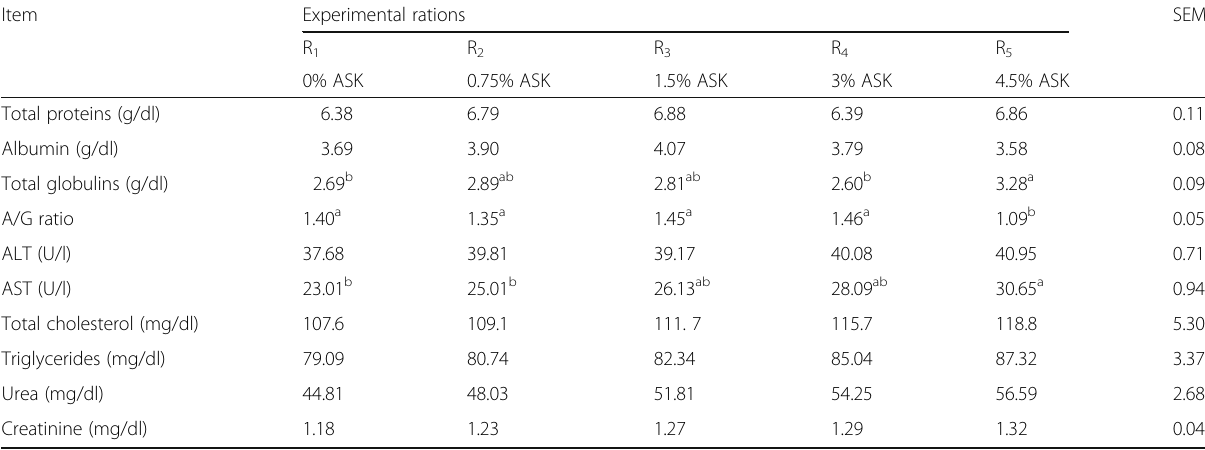
Table 6 Serum biochemical changes of the experimental groups